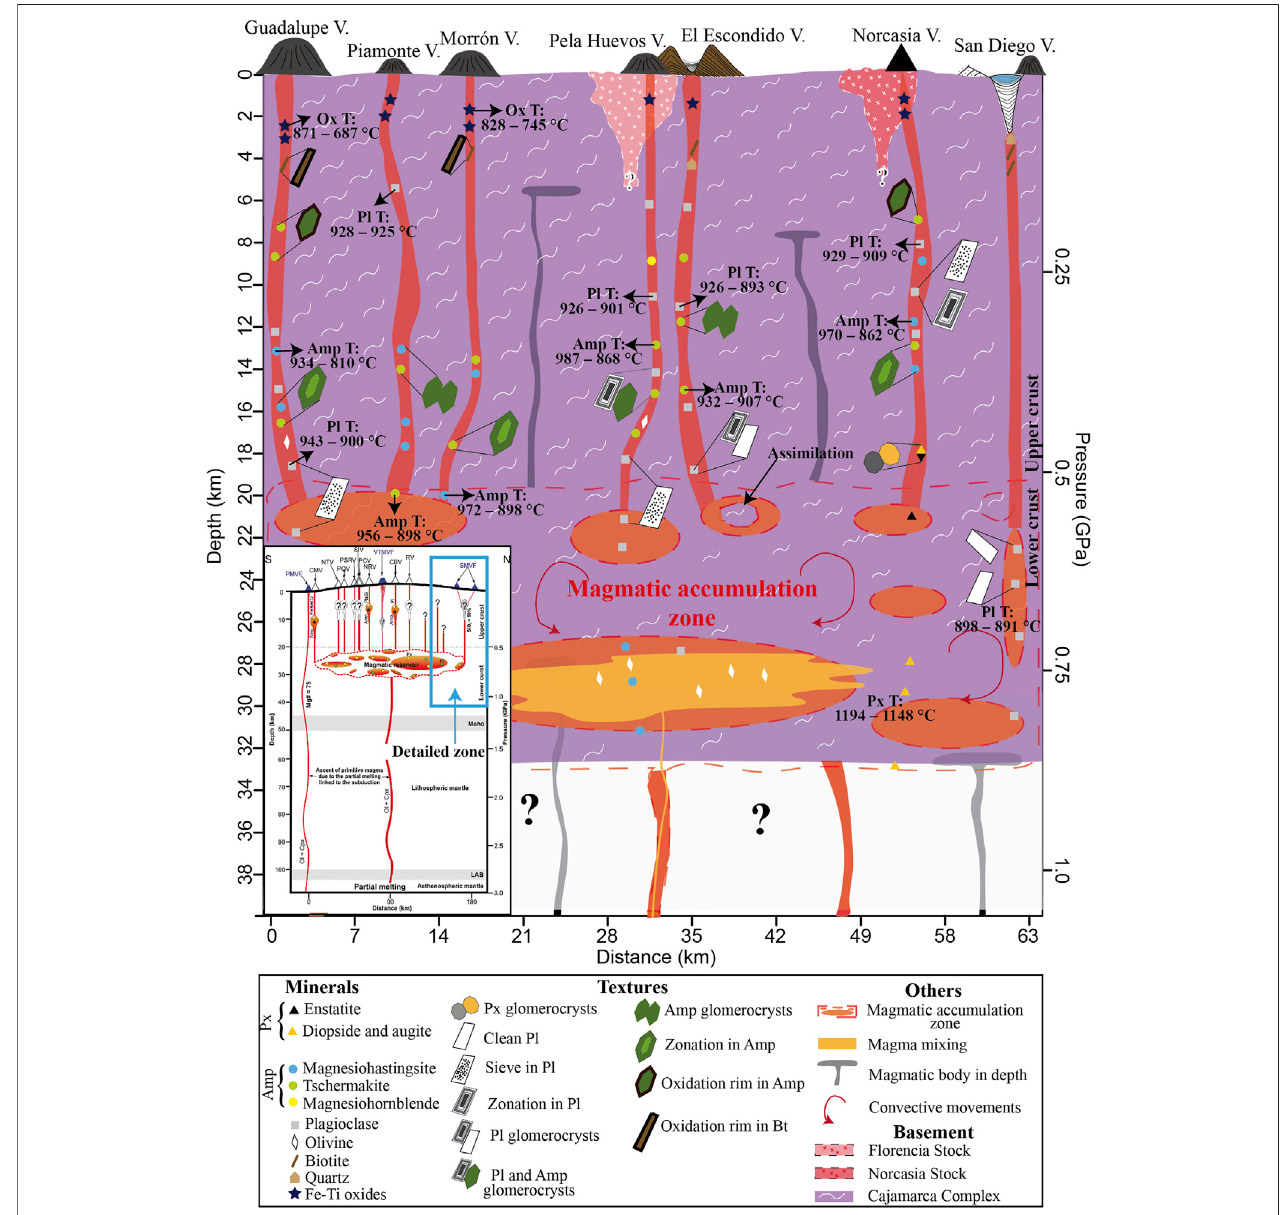
FIGURE 11 | Samaná monogenetic volcanic fi eld magma evolution model. The depth at which the different mineral phases were formed is obtained by the equation h = [P/( ρ × g)] (White, 2013). Extrapolated depth of the Cajamarca Complex at 6,5 ° N (Ureña & Mejía, 2019). In the lower left part, the San Diego — Cerro Machín Volcano-Tectonic Province model is observed (from Murcia et al., 2019), where the blue box represents the zone which this model has proposed.